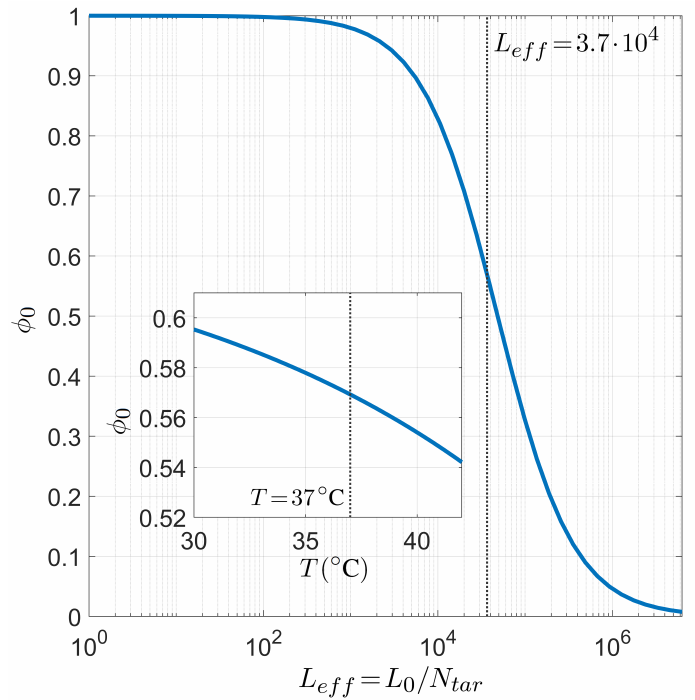
Figure 8. Dependence of the miRNA pairing probability φ 0 on the reduced transcriptome length L ef f computed with N tar = 300 for fixed temperature T = 37 ◦ C, salt concentration [ Na + ] = 150 mM, CG fraction n CG = L /2, and miRNA length L = 8. Inset: T dependence of φ 0 in the same conditions and L ef f = 3.7 × 10 4 . The gray lines mark the reference values T = 37 ◦ C (inset) and L ef f = 3.7 × 10 4 (main